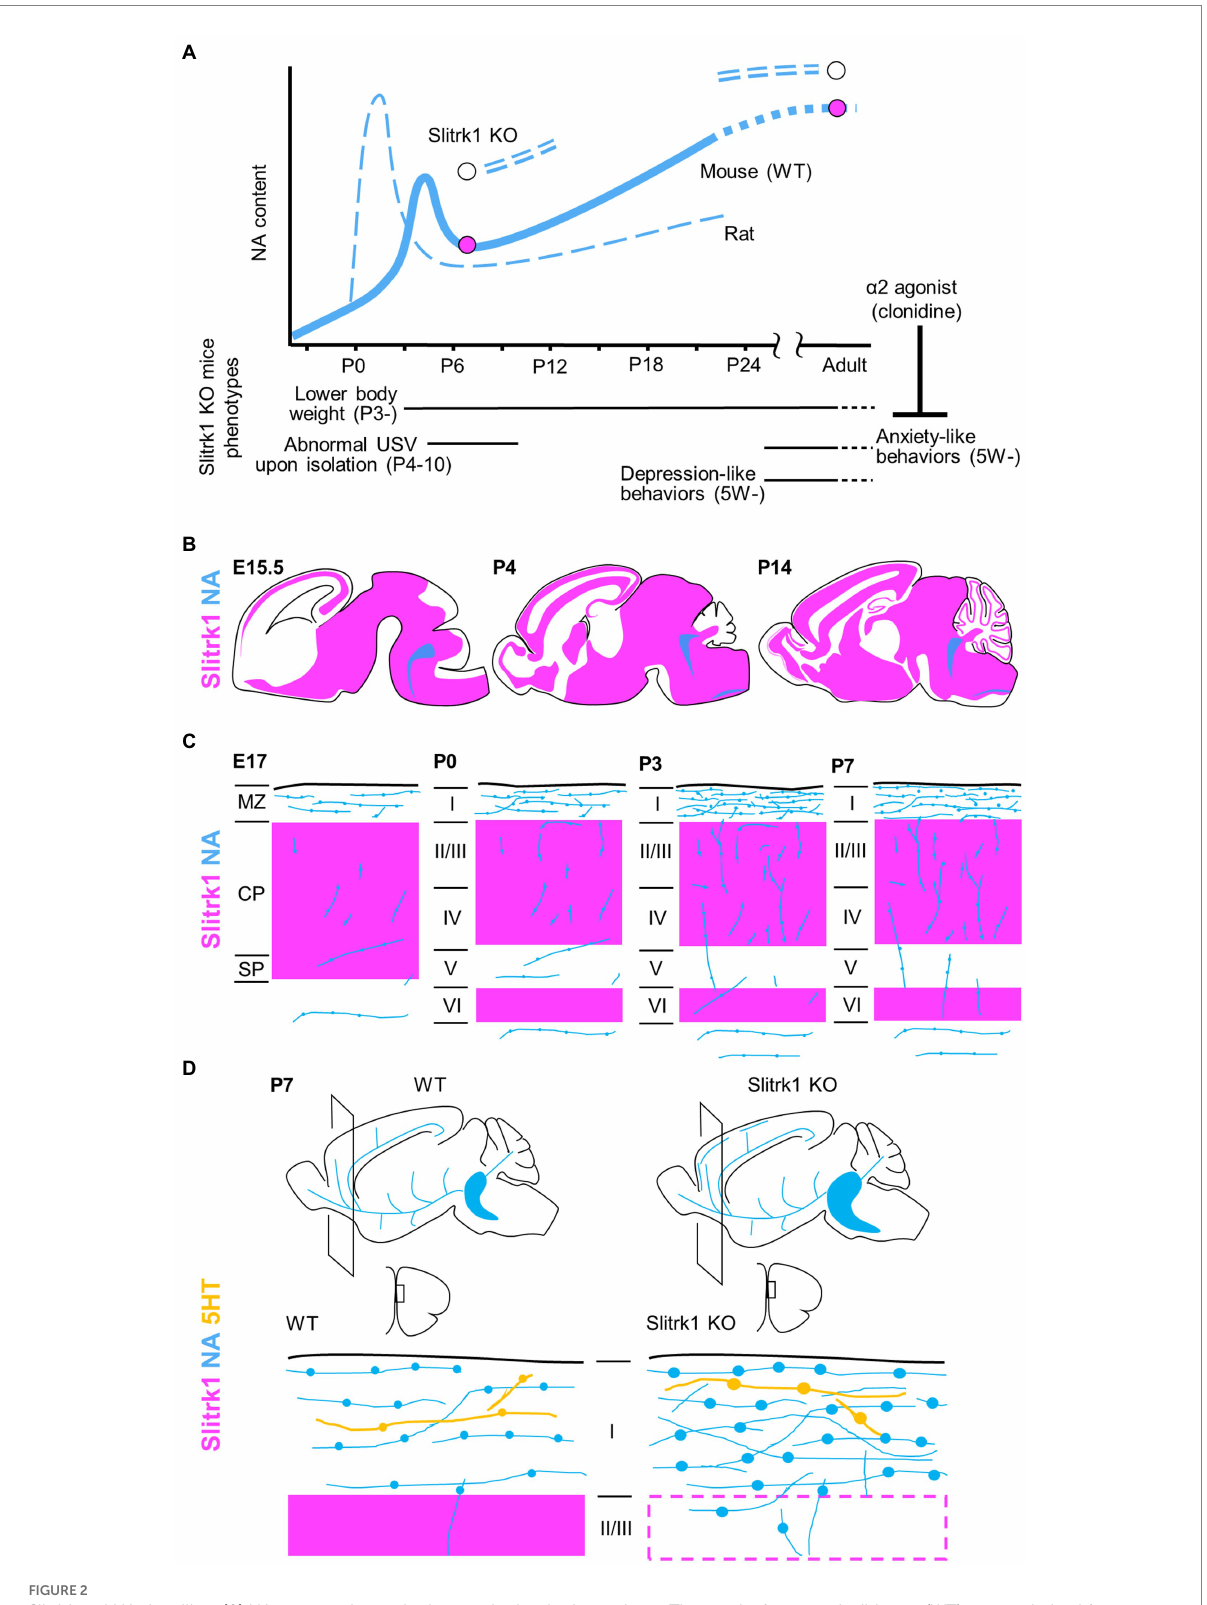
FIGURE 2 Slitrk1 and NA signalling. (A) NA contents in cerebral cortex in developing rodents. The graphs for rat and wild-type (WT) mouse derived from Levitt and Moore (1979). NA contents are increased in PFC of Slitrk1 KO mice both at P7 and adult stages. Slitrk1 KO